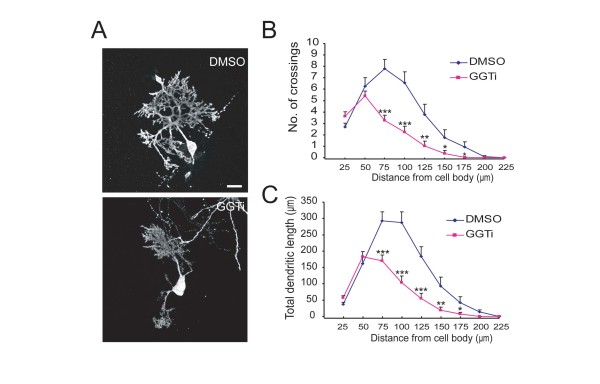
Inhibition of GGT impedes dendrite development of PCs. P11 rat cerebellar slices at DIV2 were transfected with pCAG-EYFP plasmid. At DIV3, cultured slices were treated with DMSO or GGTi-2147 (2.5 μM) for additional 3 days. A) Representative images of PCs at DIV5, after treatment with DMSO or GGTi-2147. B) Quantification for the number of crossings. C) Quantification for total dendritic length between neighboring circles at indicated distance from soma. Data are shown as means ± SEM (n = 31 for control; n = 31 for GGTi-2147). *P < 0.05, **P < 0.01, ***P < 0.001; Student's t test. Scale bar = 20 μm.